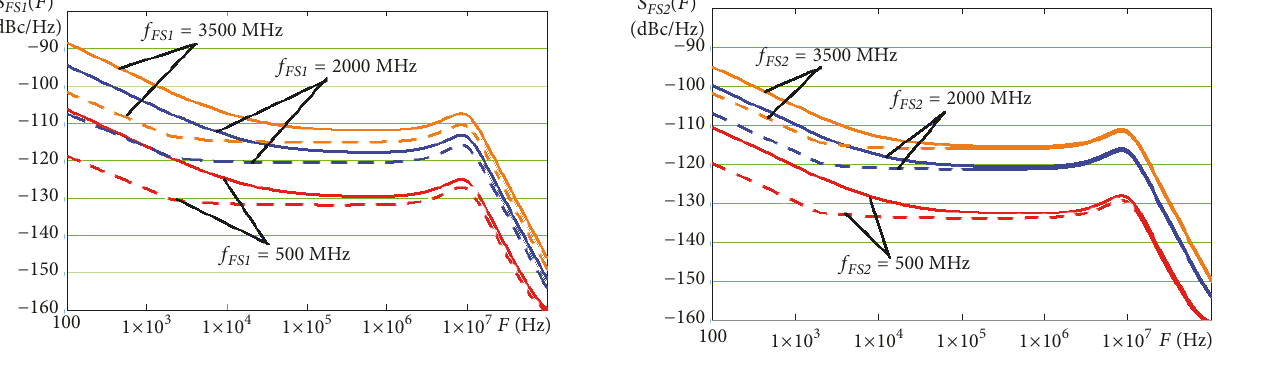
Figure 11: SPD of phase noises of a hybrid frequency synthesizer with a DDS as a frequency divider in the feedback loop of the PLL and the ACPDfor output frequencies of 500 MHz ( n = 1, N = 1, 𝐾 DDS = 0,2, and 𝑛 AA = 1,95), 2000 MHz ( n = 1, N = 1, 𝐾 DDS = 0,05, and 𝑛 AA = 1,95), and 3500 MHz ( n = 1, N = 2, 𝐾 DDS = 0,057, and 𝑛 AA = 1,95).